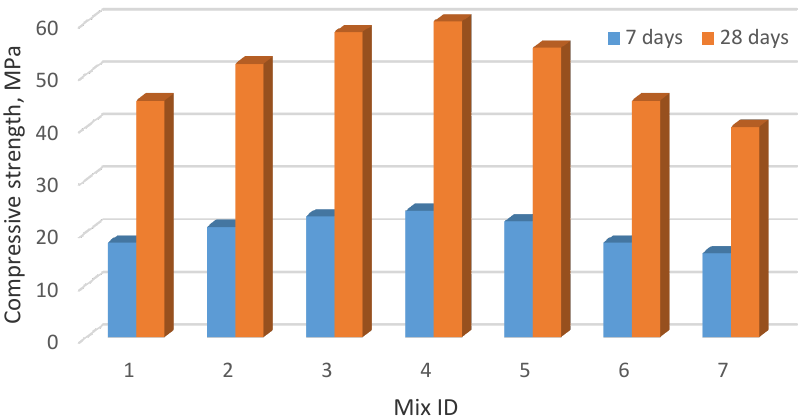
Figure 19. Change in the strength of the developed